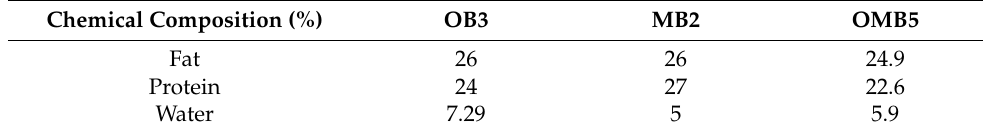
Table 2. Optimisation goal for Bambara groundnut and Moringa oleifera snack bar.